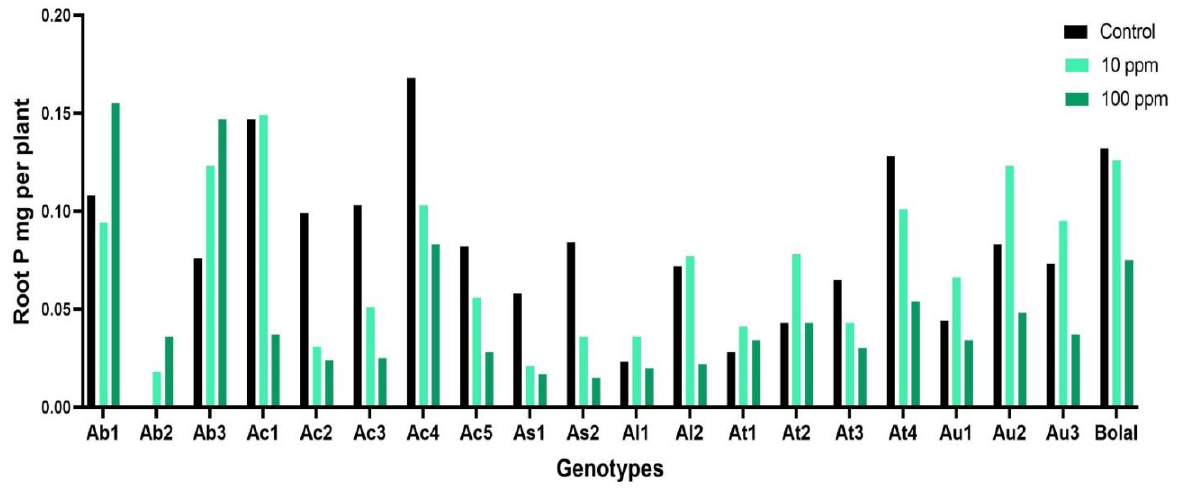
Figure 2. Variation in the RP (root phosphorus) uptake of 19 Aegilops genotypes and Bolal 2973, the B tolerant check genotype in Control (3.1 µ M B), 10 ppm B (toxic B), and 100 ppm B (highly toxic B).